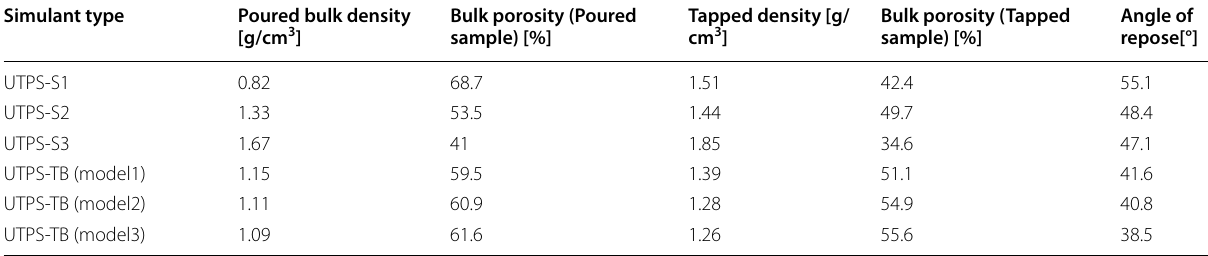
Table 5 Averaged density (poured and tapped), porosity, and angle of repose Simulant